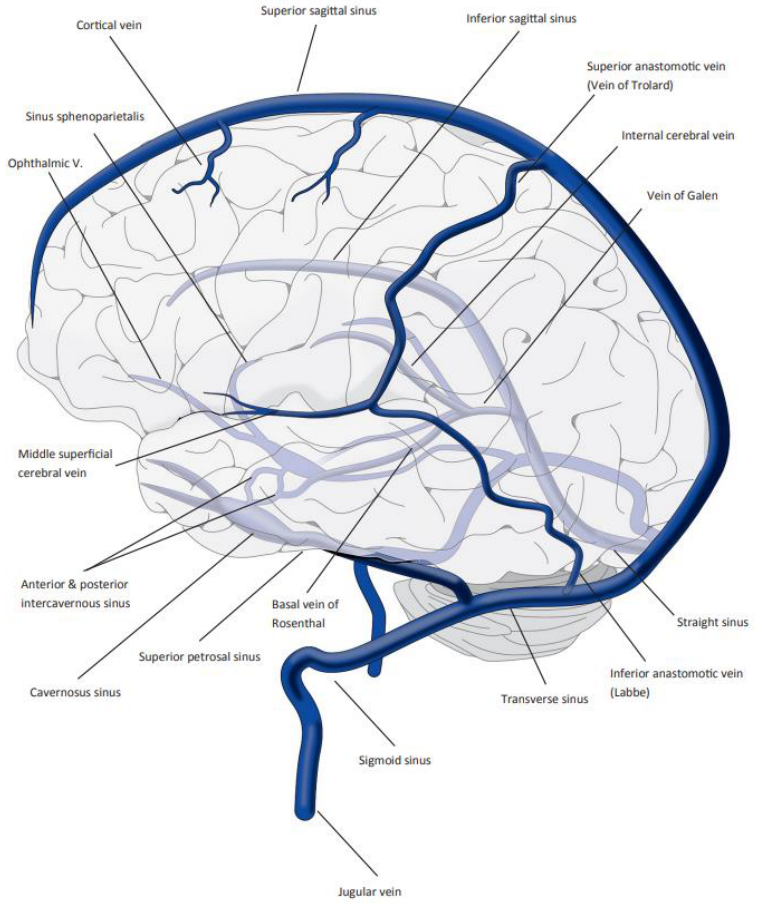
Figure 1. Illustration of the anatomy of the cerebral sinus and veins [7].